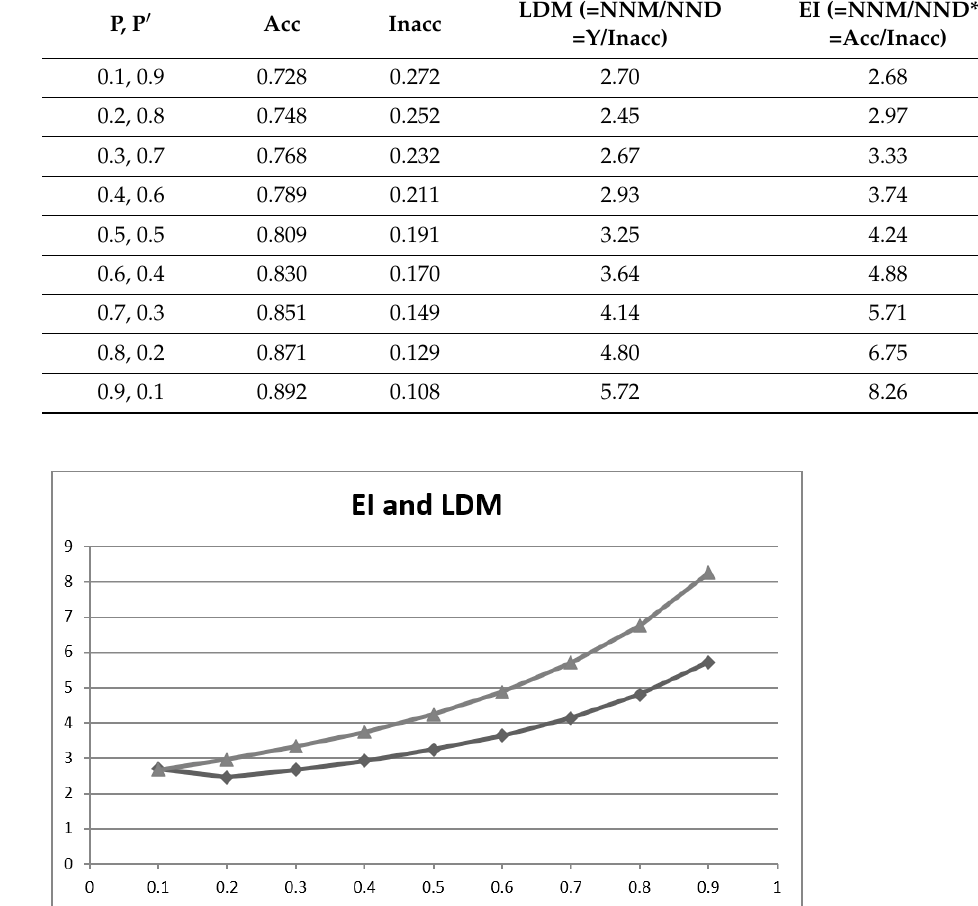
Figure 3. Plot of efficiency index (EI; upper line, triangles) and of likelihood to be diagnosed or misdiagnosed (LDM; lower line, diamonds) values (y axis) vs. prevalence of dementia (x-axis).